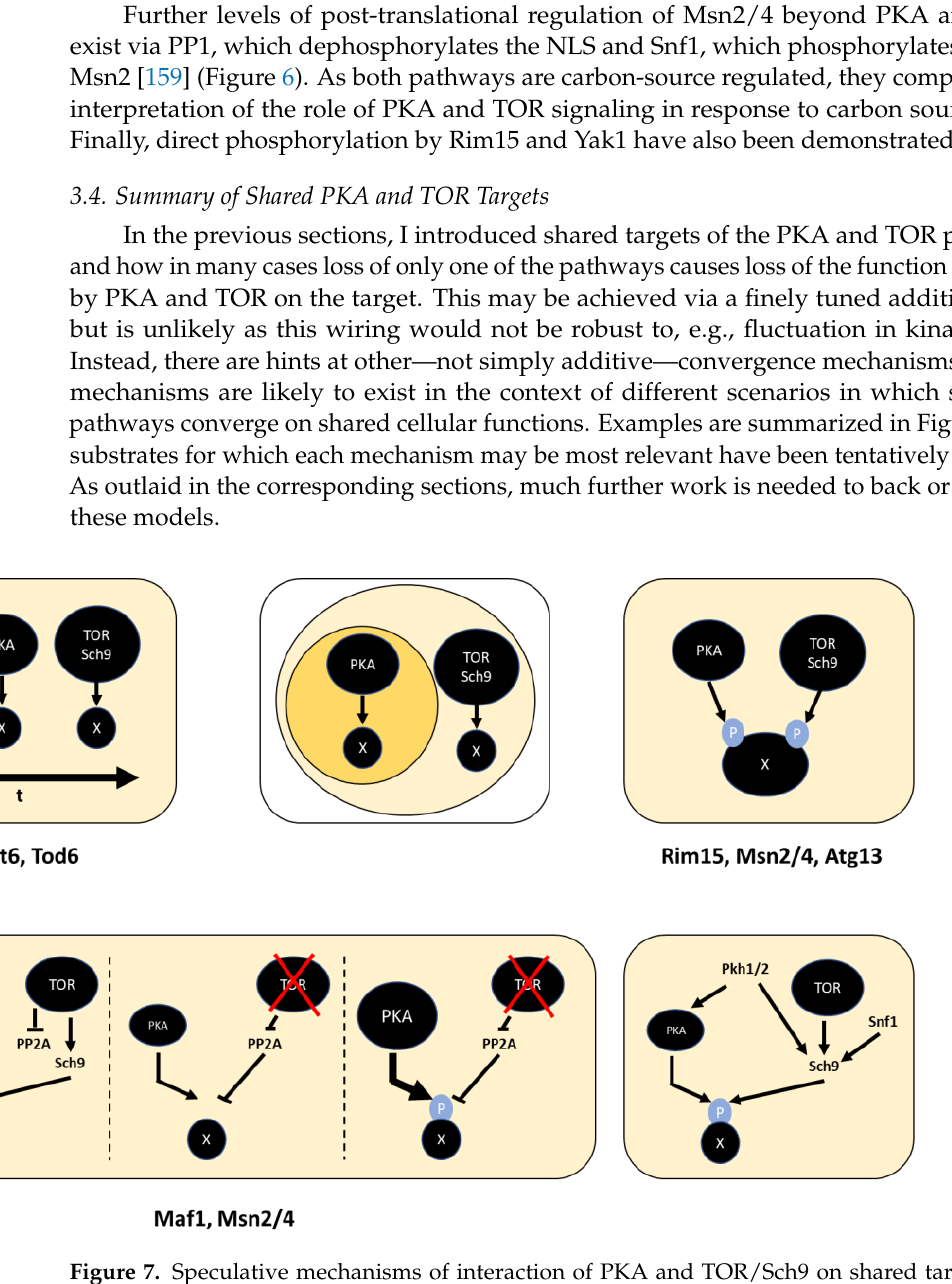
Figure 7. Speculative mechanisms of interaction of PKA and TOR/Sch9 on shared targets. Top: Differential temporal (left) and subcellular (middle) activities of the pathways. Right: Phosphorylation of different sites by the two pathways. Bottom, left: Control of substrate phosphorylation by TOR via activation of Sch9 and inactivation of PP2A. PP2A may overcome weak, but not strong PKA activity. Right: Regulation of Sch9 via pathways additional to TOR. Activation by Pkh1/2 is shared with PKA. Substrates for which the mode of interaction may be relevant are proposed.